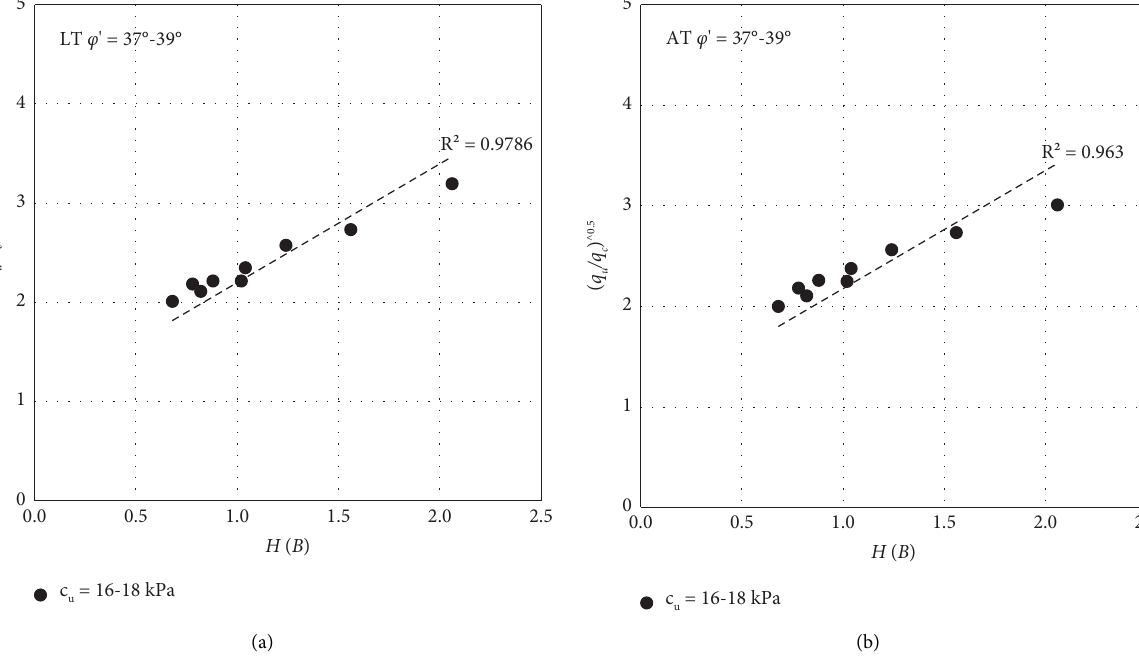
Figure 5: ( q q ) 0 . 5 versus H/B for an unstabilised granular layer (data source: (a) Lee et al. [33] and (b) Lee et al. [34]): (a) LT ϕ ′ � 37 ° –39 ° u / c and (b) AT ϕ ′ � 37 ° –39 °